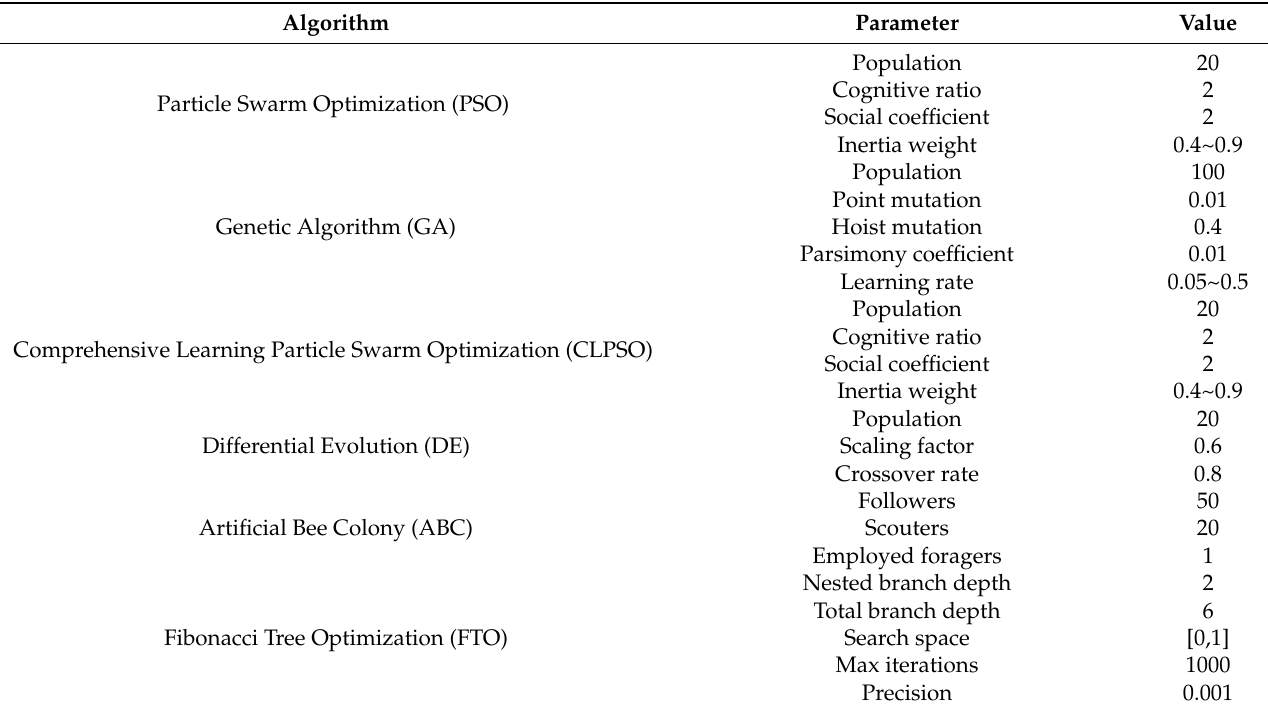
Table 10. The algorithm parameters adopted.